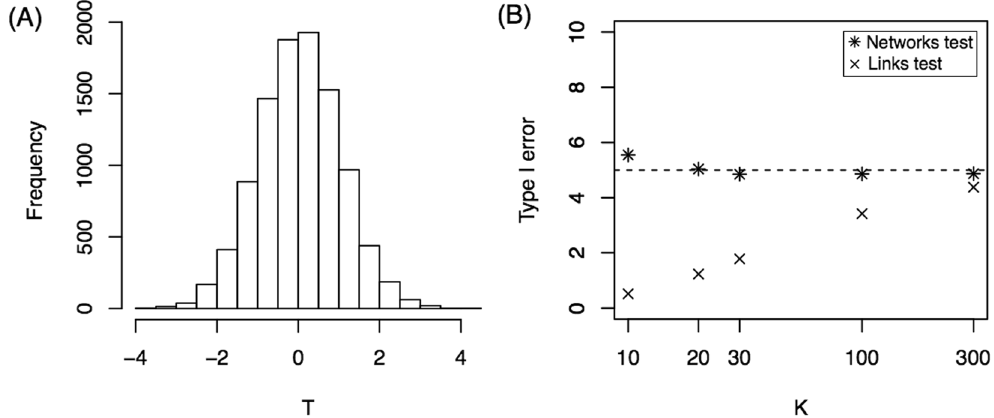
Figure 2. Null hypothesis. ( A ) Histogram of T statistics for K = 30. ( B ) Percentage of Type I Error as a function of sample size, K . Both tests are